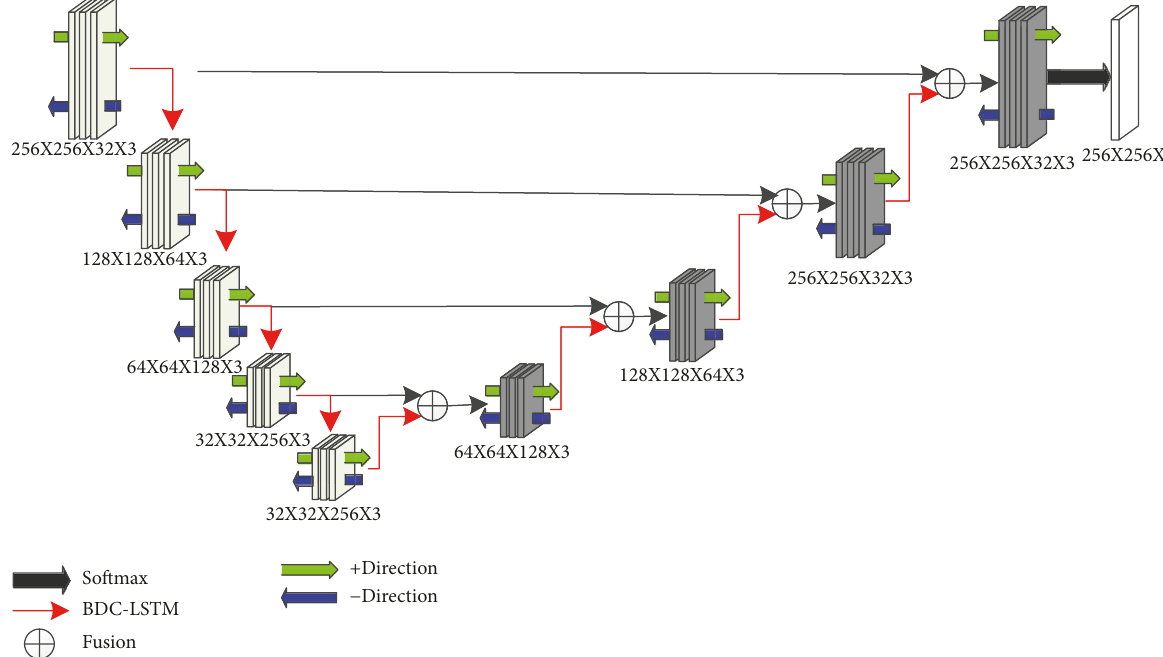
Figure 10: Architecture of the proposed